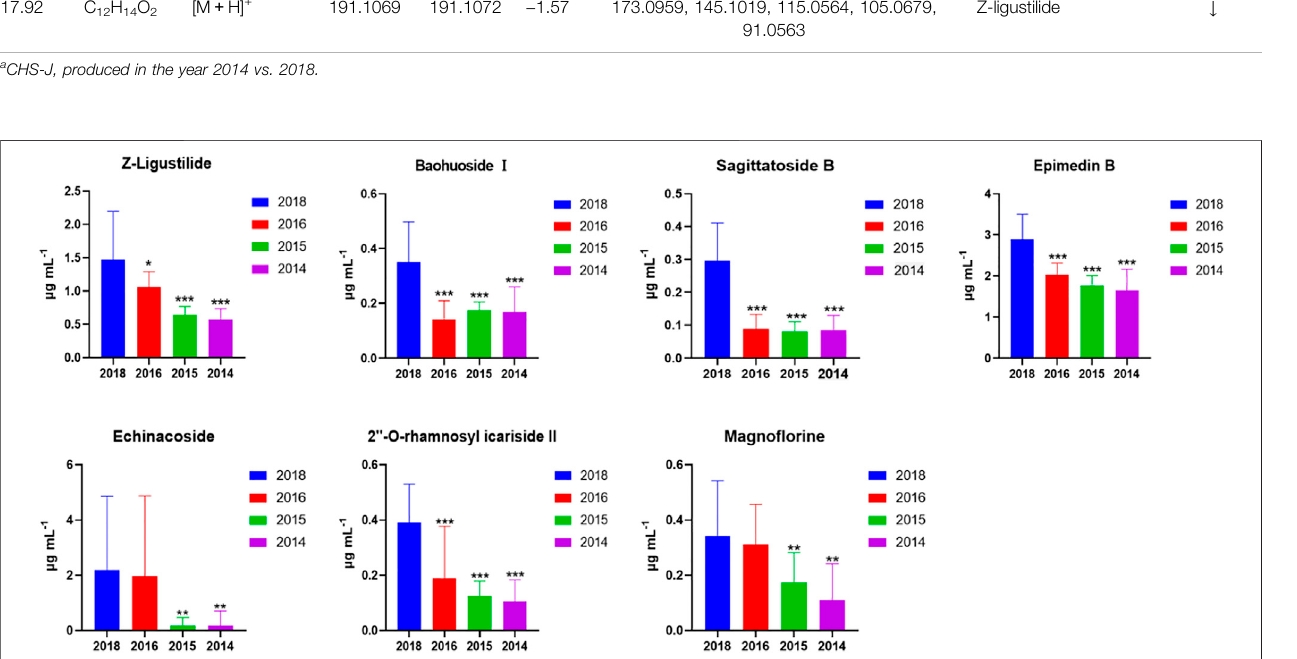
Frontiers in Pharmacology |